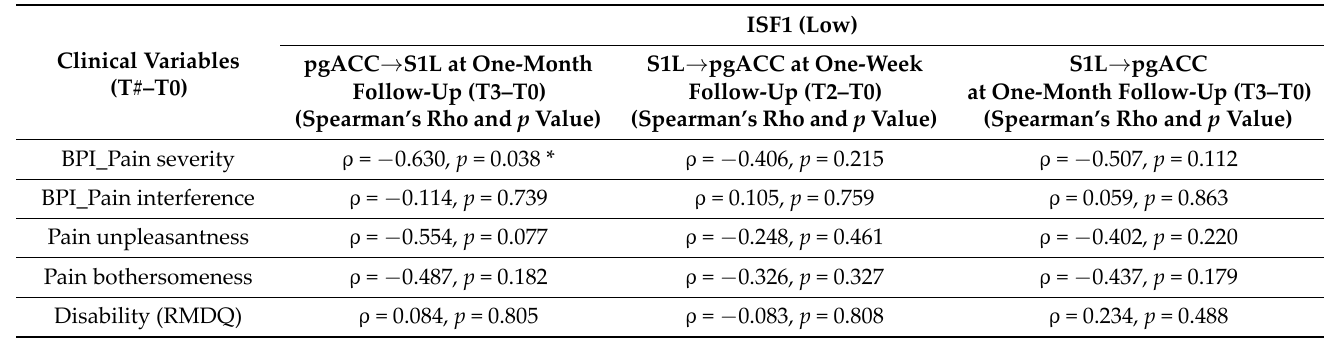
Table 4. Result of the correlation analyses between the changes in the effective connectivity measures and the changes in clinical